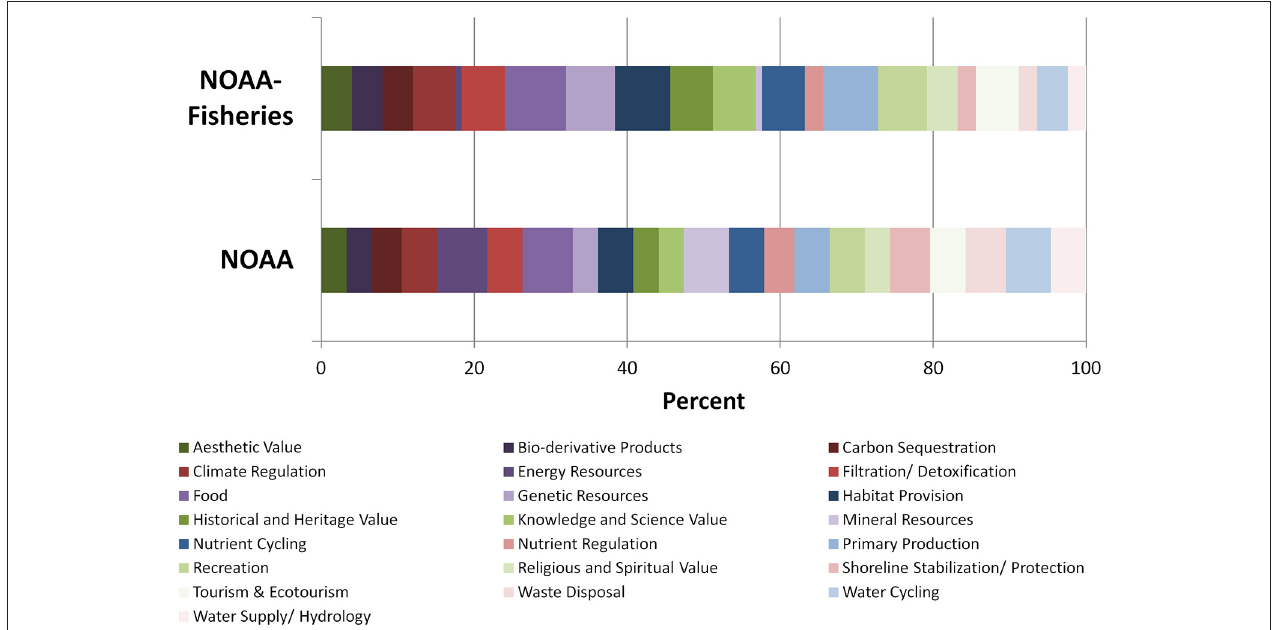
FIGURE 1 | The relative priority of each EGS to NOAA’s mission, and to NOAA-Fisheries’ mission was estimated. Here we visualize the weight of each EGS as a percentage of the total (100%) for NOAA and NMFS. EGS are graphed in alphabetical order. Provisioning services are indicated with purple hues. Supporting services are indicated with blue hues. Regulating services are indicated with red hues. Cultural services are indicated with green hues. EGS are listed in alphabetical order.